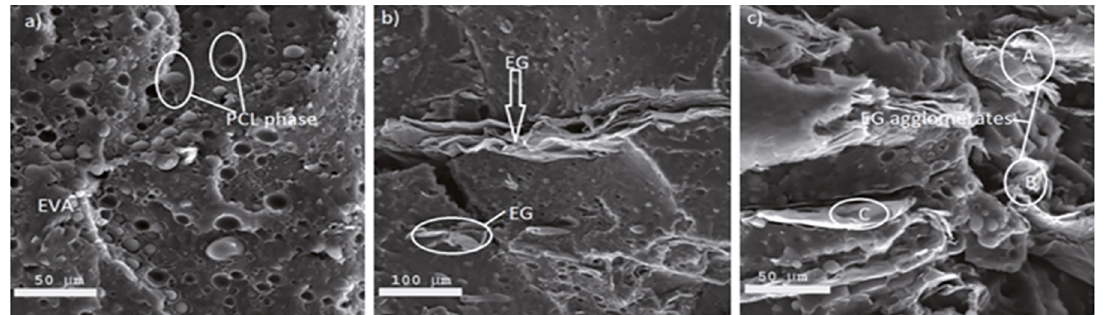
Figure 2: Unetched scanning electron micrographs of a) EVA/PCL blend , b) 70/30 w/w EVA/PCL+ 5phr EG and (c) 70/30 w/w EVA/ PCL+ 15phr